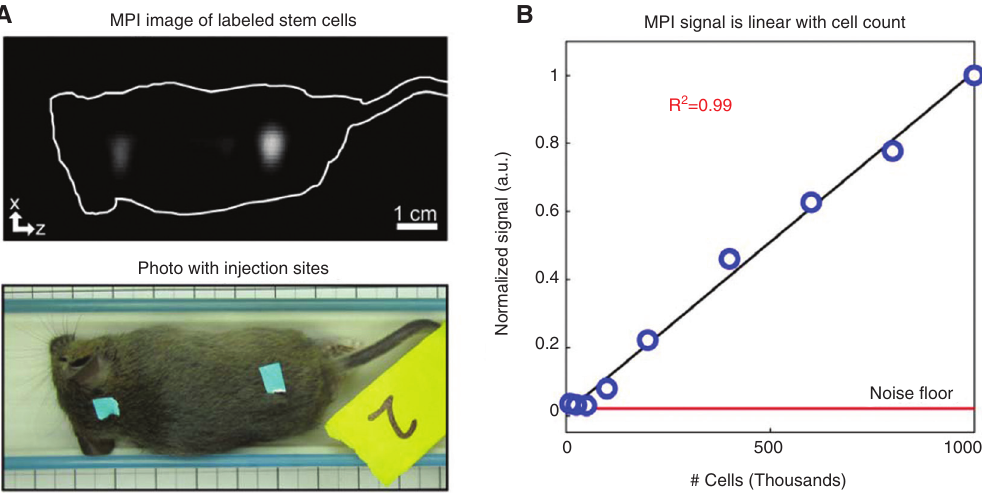
Figure 12 Stem cell imaging with MPI. (A) Projection MPI image of two injections of hESC-derived cells (1 × 10 5 cells on the left vs. 2 × 10 5 cells on the right site) introduced subdermally into a postmortem mouse (injection sites marked in cyan in the photo). The ratio of signal intensi- ties between the right and left injection regions in the MPI image was found to be 2:1. Image acquisition time was 3 min total with FOV of 5 × 10 cm and 16 averages. (B) Plot of MPI signal intensity vs. number of stem cells in scanner, demonstrating excellent linear fit (R 2 = 0.99). MPI images were acquired for nine stem cell populations ranging from 1 × 10 4 to 1 × 10 6 cells and compared for maximum signal intensity. Our current stem cell detection threshold (i.e., the noise floor) is limited by system interference and is approximately 1 × 10 4 cells in our proto- type system. (Reproduced with permission from Ref. [176], Copyright Elsevier,